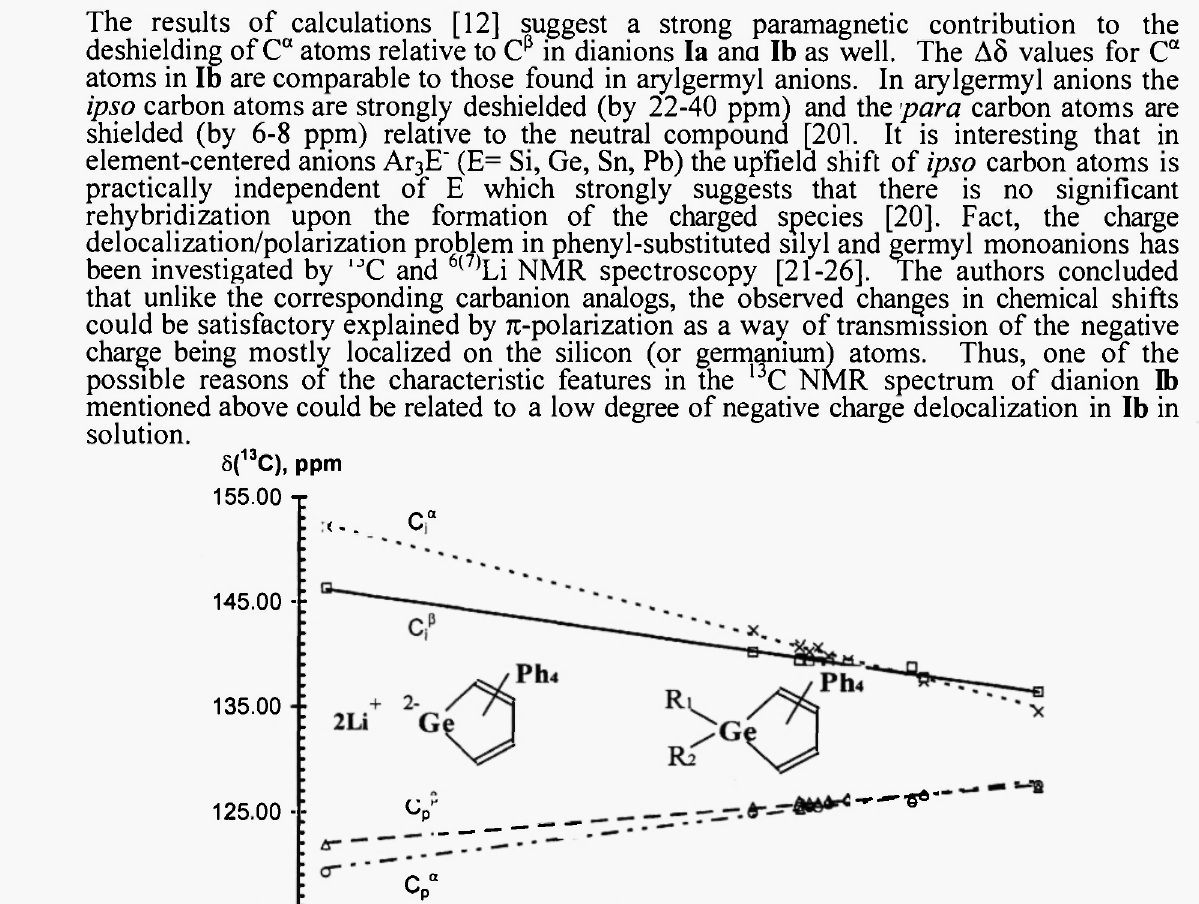
Figure 2. Correlation between the chemical shifts of the carbon atoms in germoles II